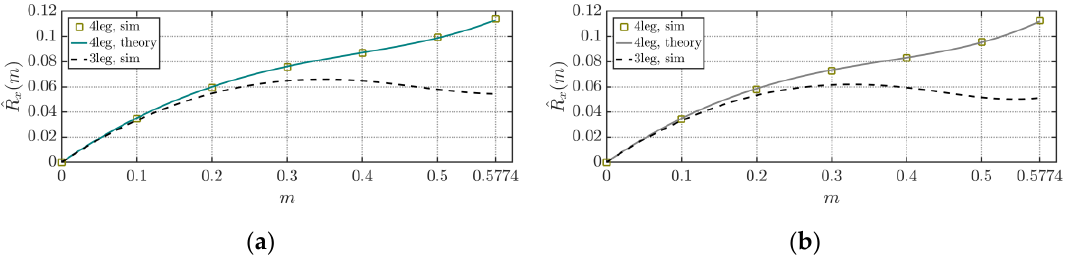
Figure 22. Normalized current ripple rms as a function of m for: ( a ) DPWM1; ( b ) DPWM3.